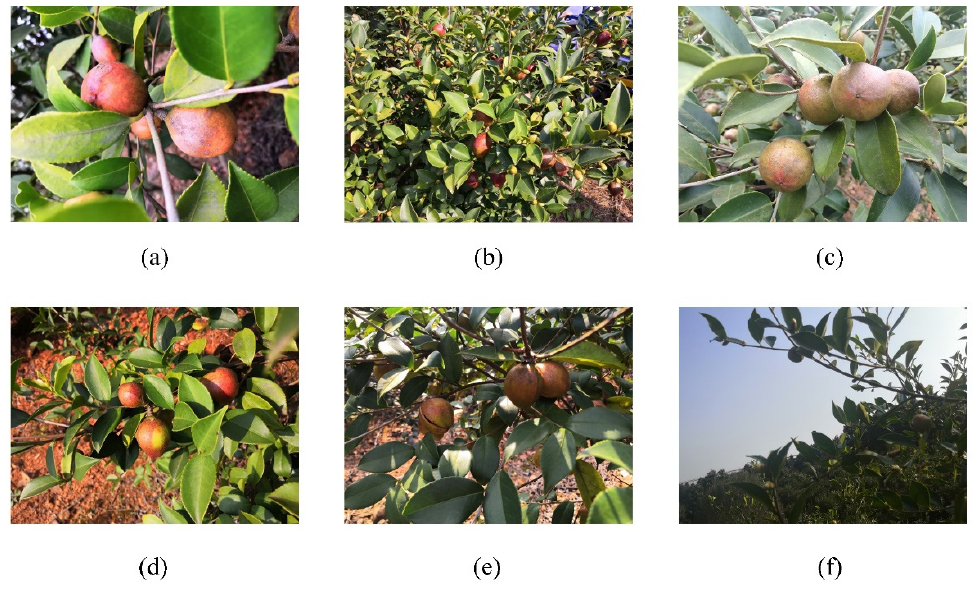
Figure 1. Examples of Camellia oleifera fruit images acquired under different conditions. ( a ) slight occlusion, ( b ) heavy occlusion, ( c ) overlapped Camellia oleifera fruit, ( d ) natural light angle, ( e ), sidelight angle and ( f ) backlight angle.